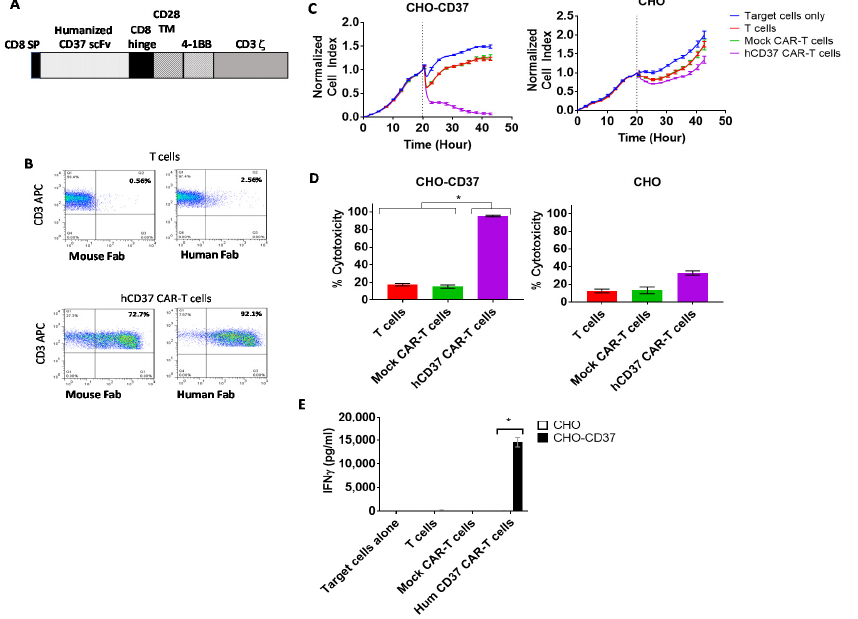
Figure 3. The humanized CD37-CAR-T cells specifically target CD37-positive cells. ( A ). The structure of humanized CD37-CAR-T cells. The structure includes CD8 signaling peptide; humanized CD37 ScFv, CD8 hinge, CD28 TM (transmembrane domain); 41BB domain; CD3 zeta activation domain. ( B ). FACS with mouse and human FAB detected CAR-positive cells. ( C ). Humanized CD37-CAR-T cells killed CHO-CD37-positive cells and did not kill CHO cells. ( D ). Quantification of cytotoxicity